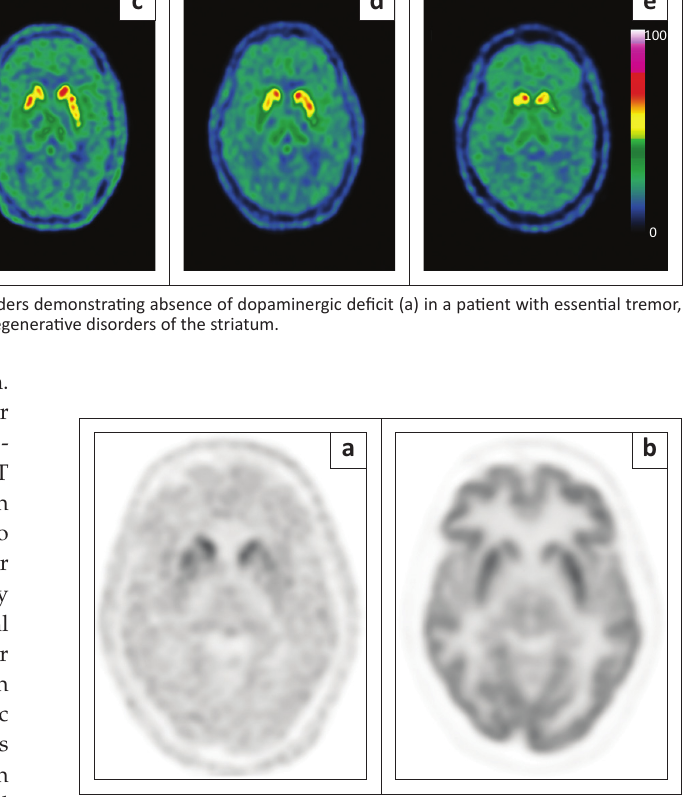
FIGURE 4: Fluorine-18 FDOPA (a) and FDG (b) PET scans in a patient with a movement disorder. The FDOPA PET convincingly demonstrates dopaminergic loss in bilateral putamina, while the FDG study demonstrates normal metabolism. These features are consistent with a diagnosis of idiopathic Parkinson’s